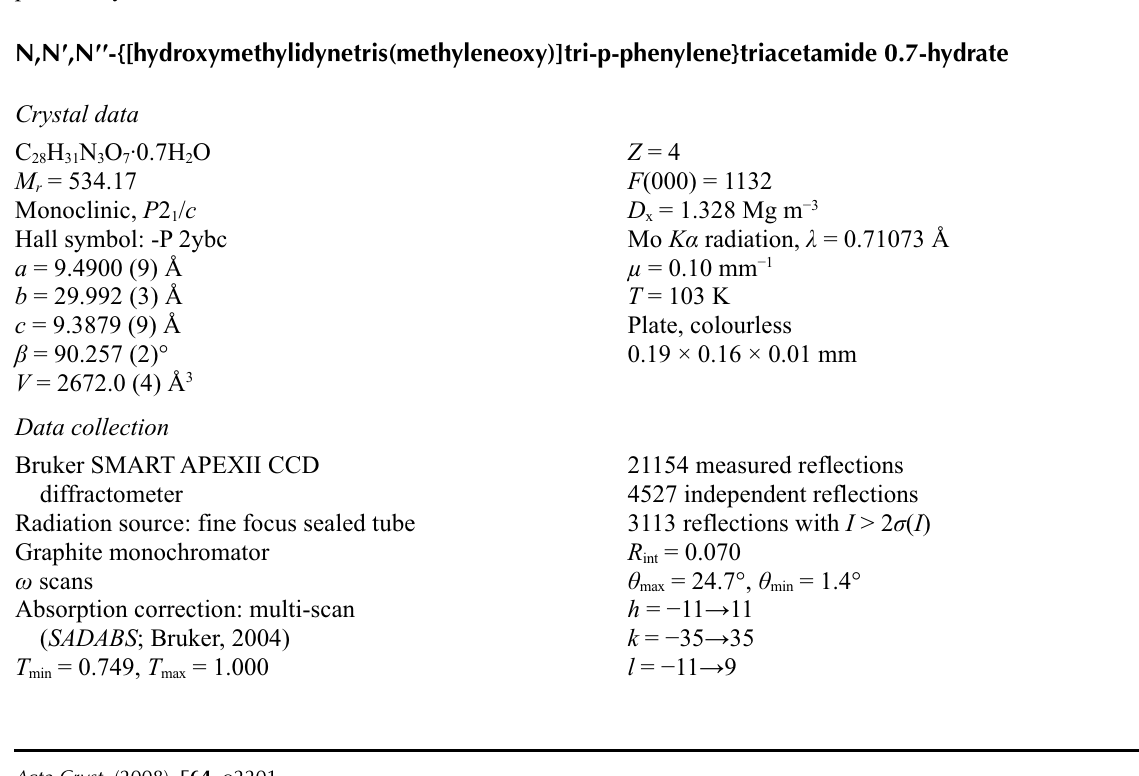
Figure 1 View of (I) showing the atom labeling for the non-hydrogen atoms. Displacement ellipsoids are shown at the 50% probability